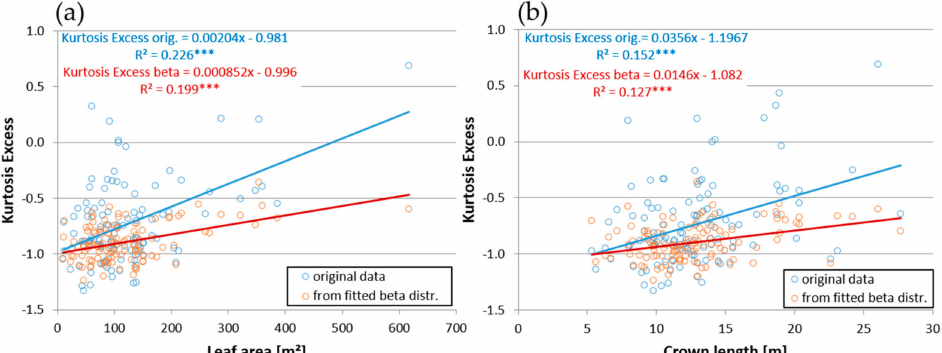
Figure 5. ( a ): The relationship between the individual tree leaf area of larch and the kurtosis excess of the leaf area distribution. ( b ): The relationship between the individual crown length of larch and the kurtosis excess of the leaf area distribution. Regression lines in ( a , b ) are once calculated from the original data without fitting a beta distribution (original data) and once calculated from the estimated parameters. *** indicates the significance for type-one error probability of